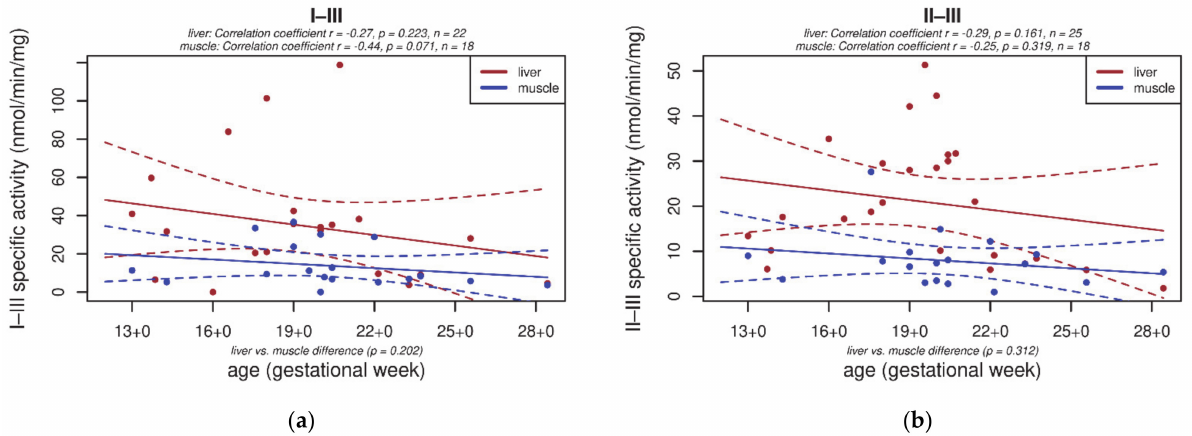
Figure A1. Tissue-specific changes in electron transport chain (ETC) complexes’ coupled activities in foetal human liver and skeletal muscle. In the liver (red) and in skeletal muscle (blue), coupled activities of complexes I–III ( a ) and II–III ( b ) were decreasing between the 13th and 28th week of gestation, but not significantly. Enzyme activities are shown as specific activity (nmol/min/mg). Statistical analyses were performed in STATISTICA 12.0 (StatSoft, Tulsa, OK, USA) and R (“R Core Team” URL: http://www.r-project.org/ accessed on 3 May 2021). The dashed line indicates 95% confidence level. I–III—NADH:cytochrome c oxidoreductase, II–III—succinate:cytochrome c